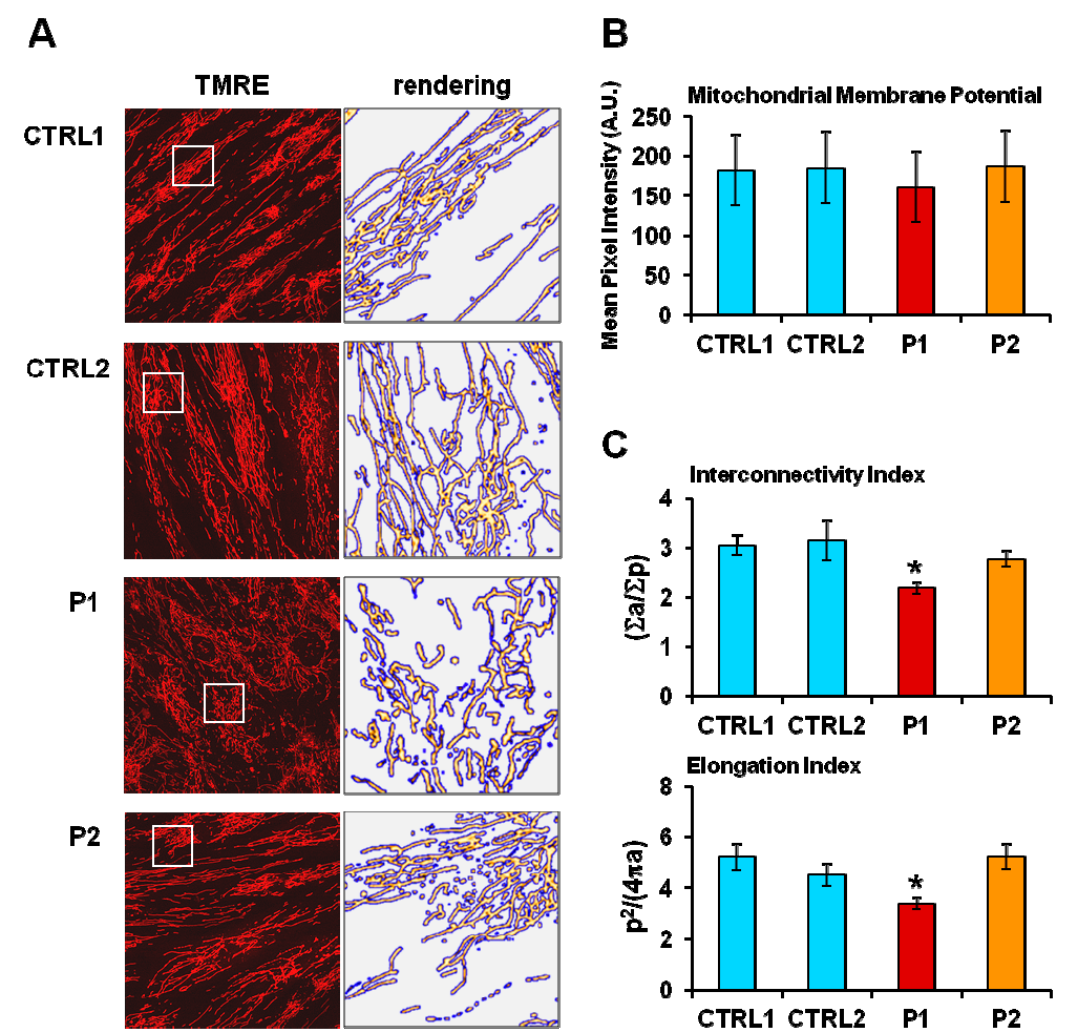
Figure 3. ( A ) Representative confocal images of mitochondrial membrane potential and morphology in two different normal fibroblasts (CTRL) and in PD patient ‐ derived (P1 and P2) fibroblasts. Cells were treated with the fluorescent probe tetramethylrhodamine ethyl ester (TMRE) as described in the Materials and Methods: the objective magnification was 60×. The panels on the right are enlargements of details shown as white square displaying the mitochondrial network after removal of the background and rendering of the TMRE ‐ related pixel intensities with false color images by ImageJ software. ( B ) Statistical analysis of the TMRE ‐ related mean pixel intensity with the bars indicating the values averaged from 8 to 10 different optical fields from three independent experiments for each sample (± SD). ( C ) Morphometric analysis of the TMRE ‐ stained mitochondria showing the interconnectivity index ( ∑ a ∑ p) and the elongation index (p 2 /4 π a) computed as described in the Materials and Methods. The results shown are values (± SEM) averaged from a total of 15 different optical fields from three independent measurements for each sample; significance was calculated with Student’s t ‐ test * p < 0.01 vs. CTRL 1.